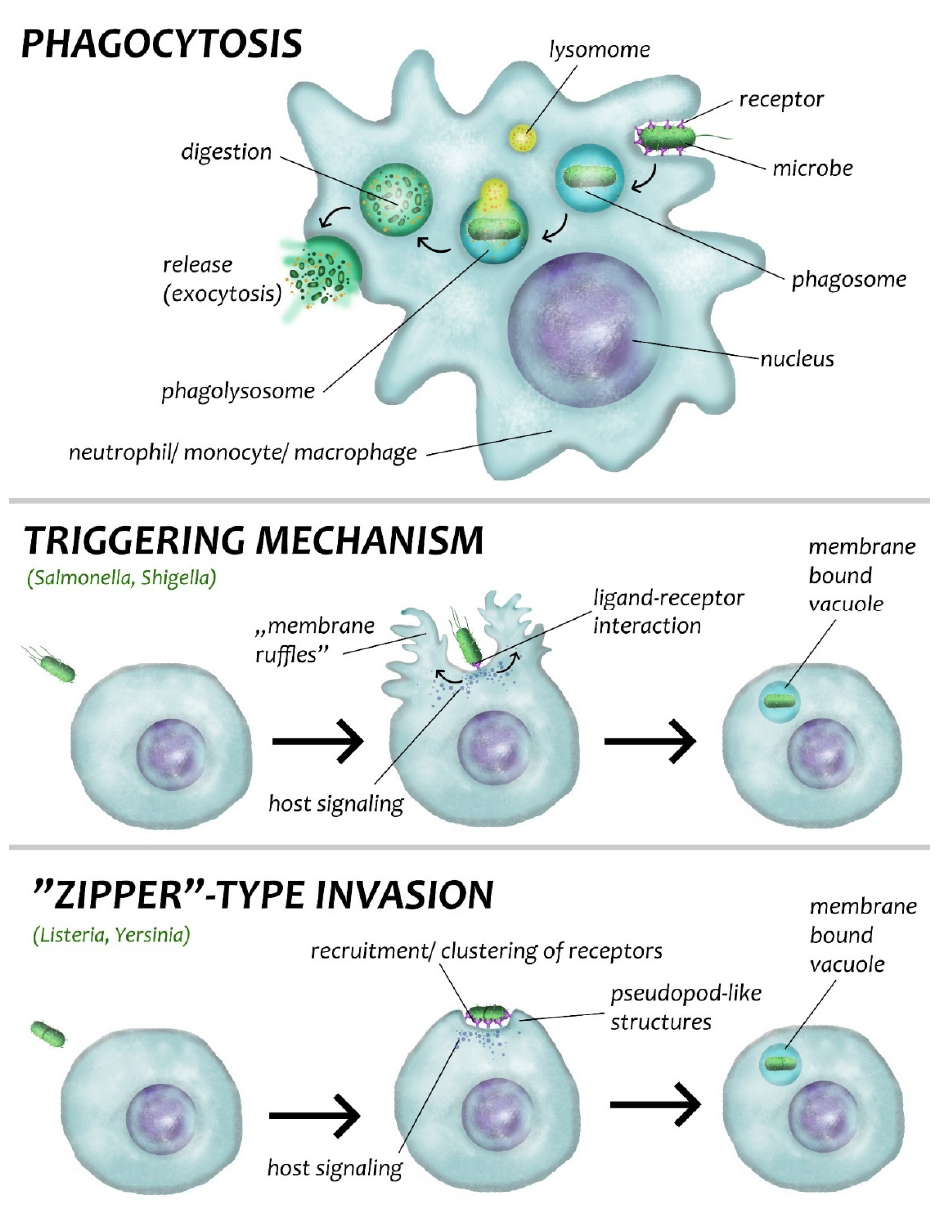
Figure 4. Schematic illustration of the ways of bacterial entry into host cells. In general, phagocytosis is the route of invasion for bacteria, the accession into professional phagocytes, for instance monocytes, neutrophils, and macrophages [15]. Copyright 2012 Silva. Salmonella and Shigella use the “triggering” mechanism their penetration into host cells, where a brief contact with the surface of the host cell eventuates a fast cytoskeletal alteration in which explosive actin polymerization in the cytoplasm pushes out large membrane extensions, the membrane ruffles [15]. The “zipper”-type invasion procedure includes a single bacterial surface ligand that tightly contacts host cell adhesion molecules. Thus, the entry process is driven by the tight binding between cell adhesion molecules and bacterial adhesins [15]. Adapted with permission from ref. [15].